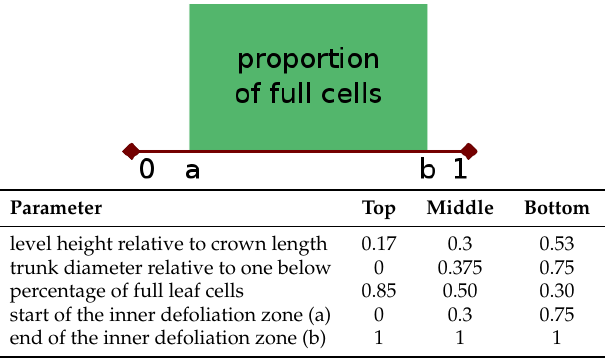
Table A2. Definition of tree crown levels with inner defoliation zone that is illustrated by parameters a and b (the horizontal axis illustrates tree crown diameter, where 0 represents the tree stem and 1 represents the crown’s periphery, adapted from DART manual [30]).